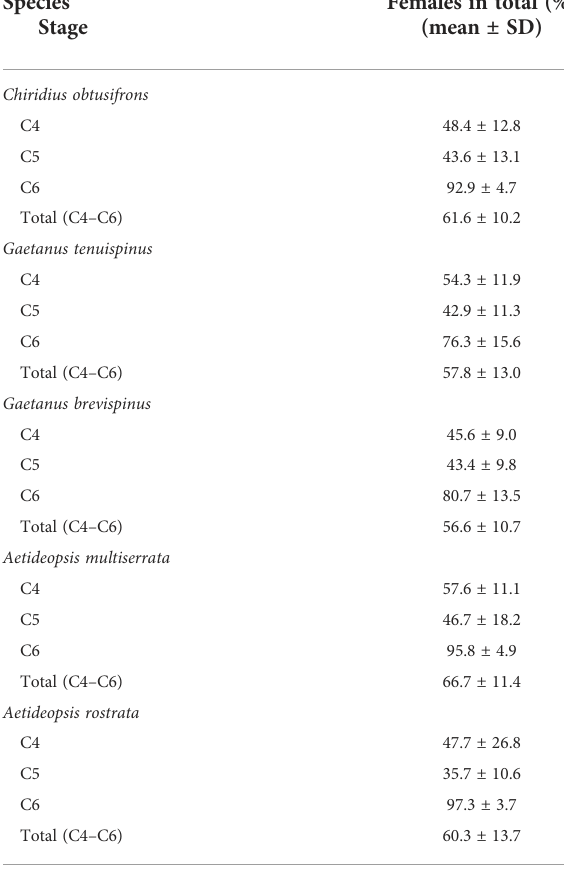
TABLE 3 Sex ratio (% of females in total population) of the fi ve Aetideidae copepods abundant in the western Arctic Ocean